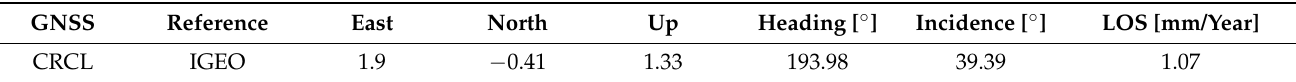
Table 2. Projection of 3D CRCL GNSS measurements to Sentinel-1 LOS direction